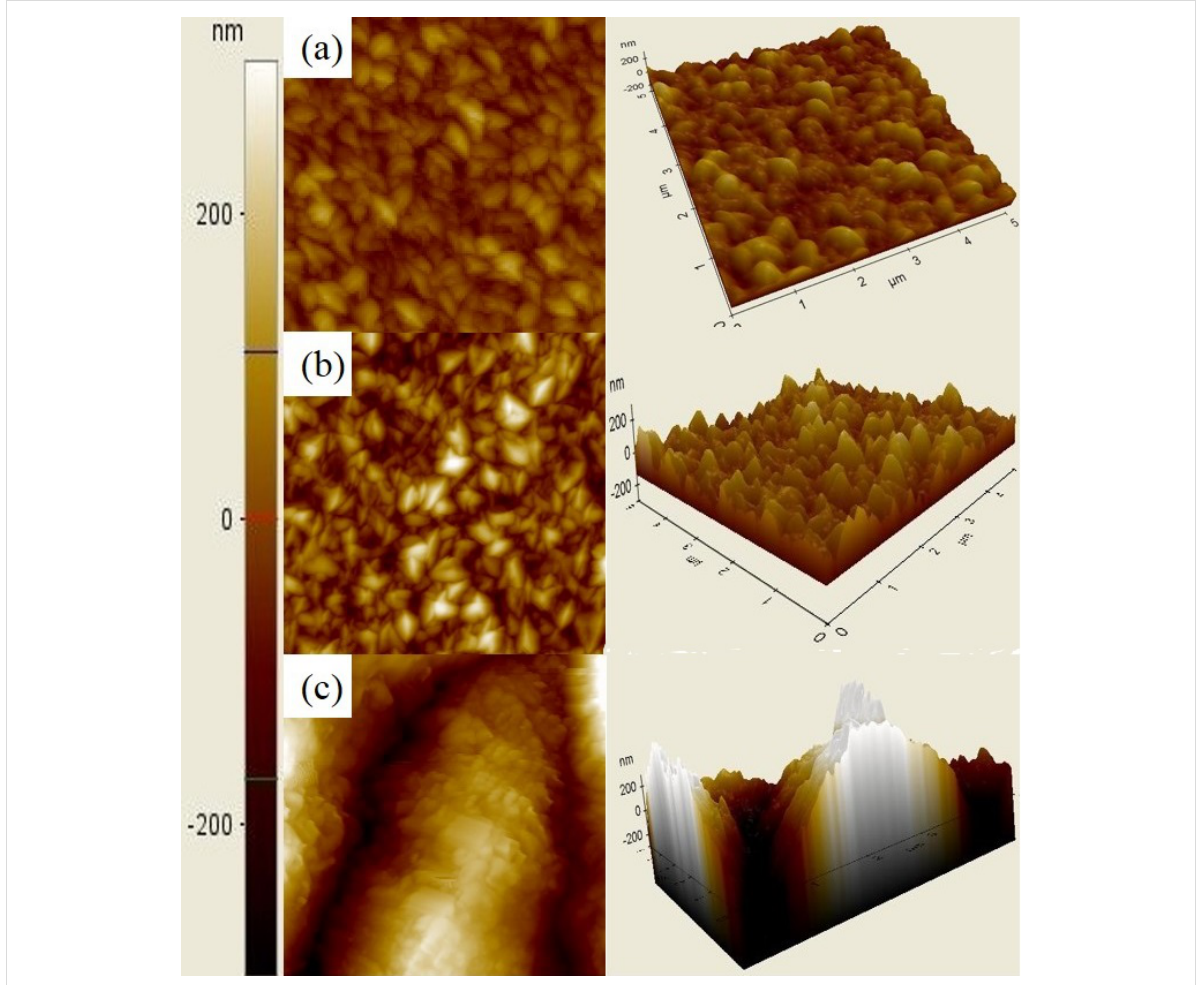
Figure 4: AFM images (5 × 5 μ m) of the samples (a) ZnO p(100) ( R q : 48.488 nm), (b) ZnO p(111) ( R q : 48.284 nm), and (c) ZnO t(100) . Surface roughness of each sample, R q , is given in parentheses when available.